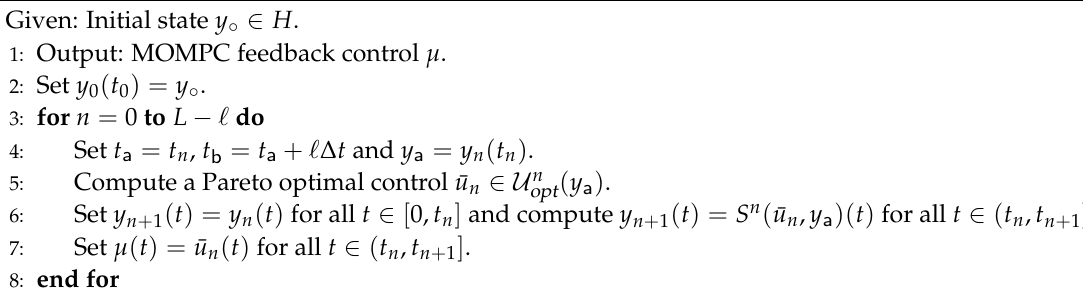
Algorithm 1 Multiobjective model predictive